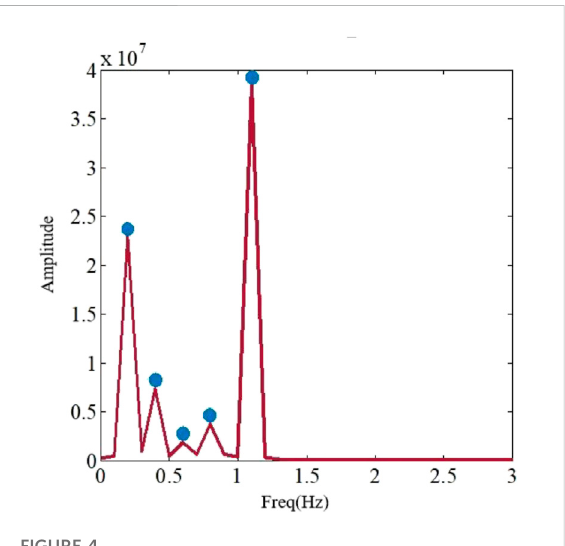
FIGURE 4 The peak plot in frequency domain.